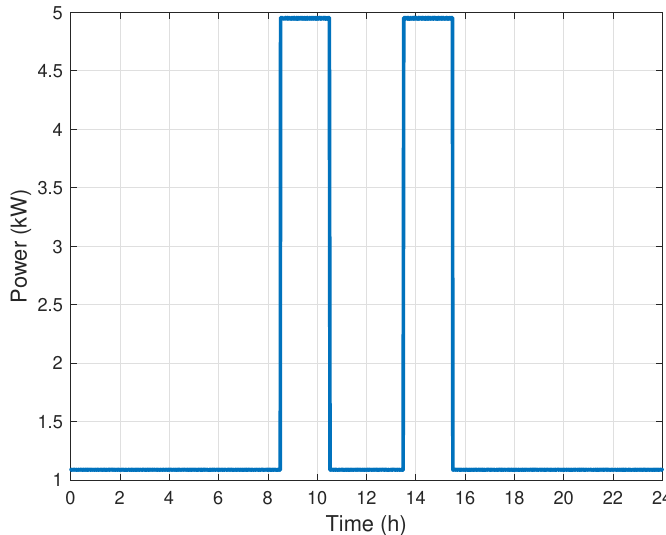
Figure A10. Office shelter equipment